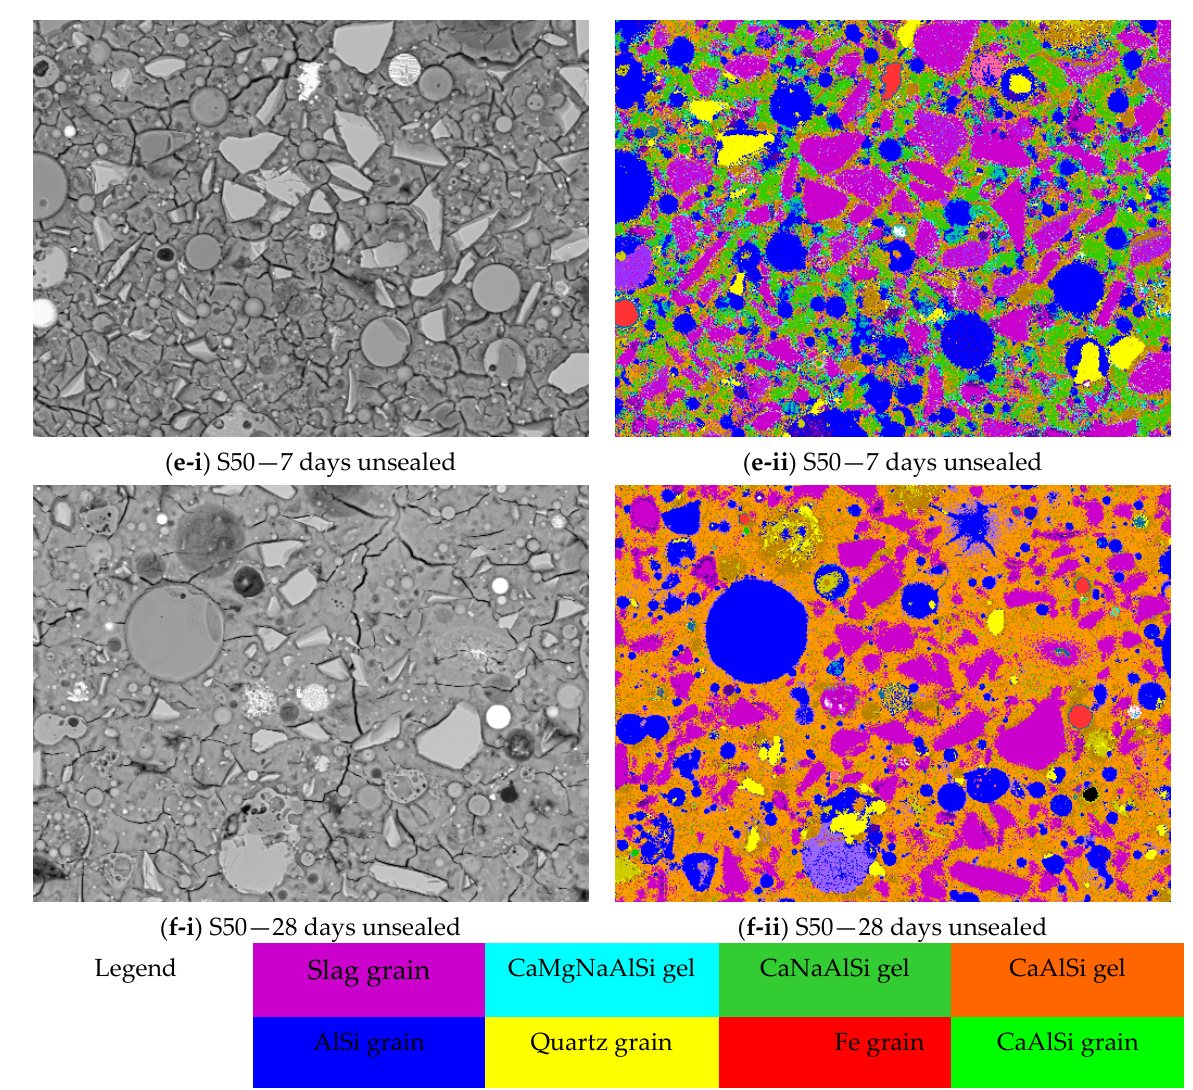
Figure 20. SEM-BSE images ( a–f-i ) of the microstructure of paste S50 at different curing periods, with mapped compound domains of different phases ( a–f-ii ). Image width = 250 μm.